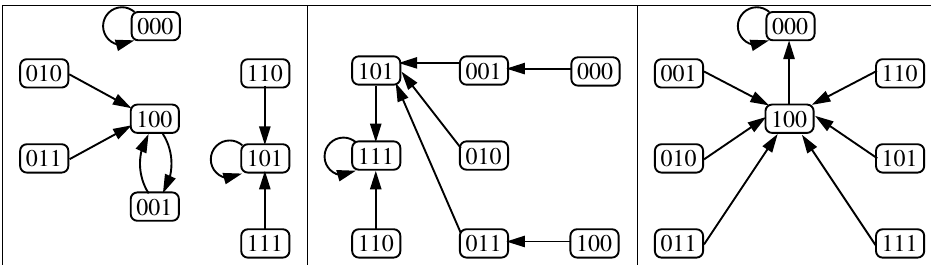
Figure 5. State transition graphs of the reduced model under parallel update schedule. Case 4 ( left ): low glucose and medium lactose. Case 3 ( center ): low glucose and high lactose. Cases 1 and 2 ( right ): the other four combination of